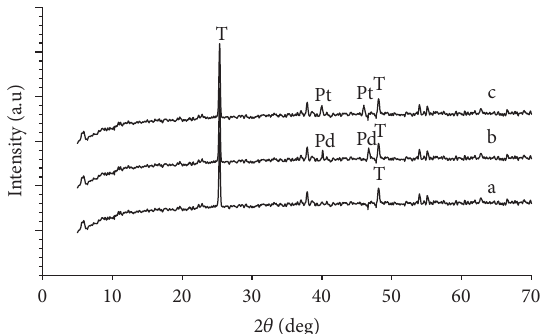
Figure 1: XRD pattern of (a) anatase TiO 2 , (b) Pd/TiO 2 , and (c) Pt/TiO 2 (T: anatase TiO 2 , Pt: platinum, and Pd: